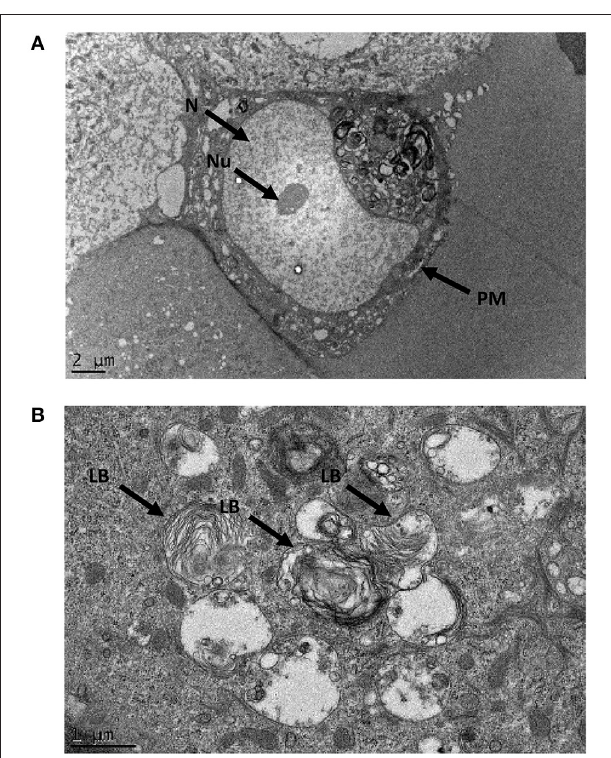
FIGURE 5 | Ultrastructural morphology of nasal epithelial cells. Resin-embedded primary nasal epithelial cells were sectioned to a ∼ 100nm thickness and visualized using transmission electron microscopy at high magnification. At an ultrastructural level, lamellar body-like structures with osmiophilic, concentric membranes could be observed in electron micrographs at a cellular (A) and subcellular (B) level. N, nucleus; Nu, nucleolus; PM, plasma membrane; LB, lamellar body-like